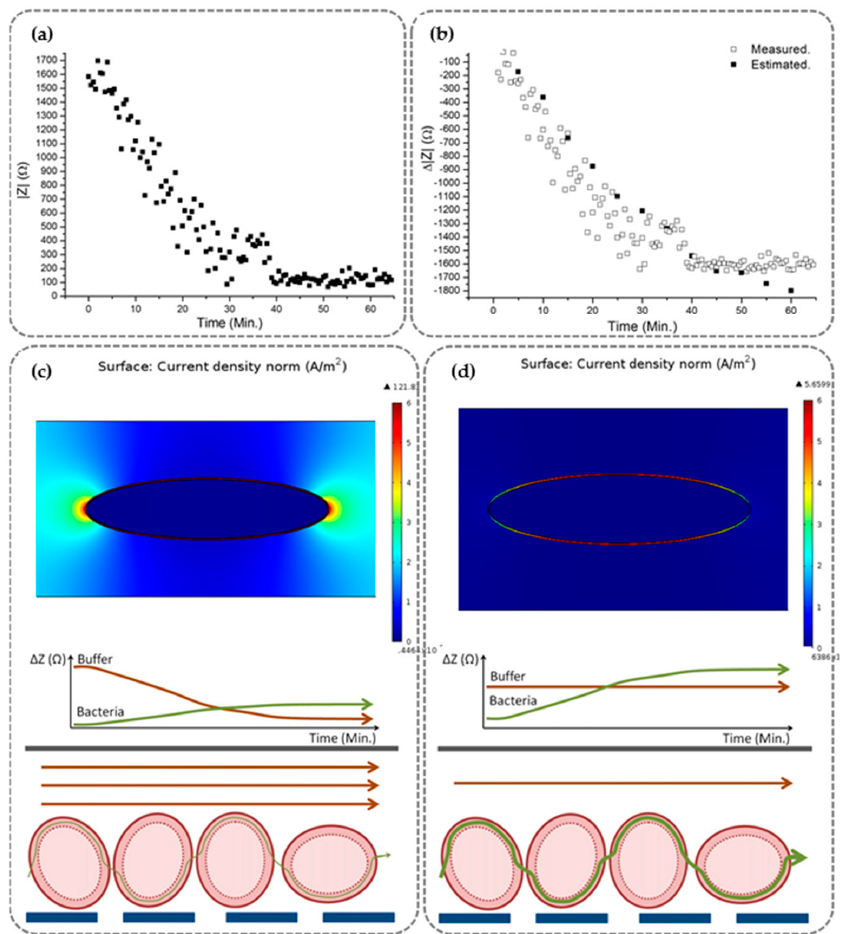
Figure 6. ( a ) Impedance magnitude; ( b ) Estimated versus experimental impedance; ( c ) Simulation of Comsol multiphysics of a single diluted cell on buffer of high conductivity steady buffer; ( d ) low-conductivity steady buffer. Flow path and influence to impedance quantification of both buffer conductivity and trapped bacteria (reproduced with permission from